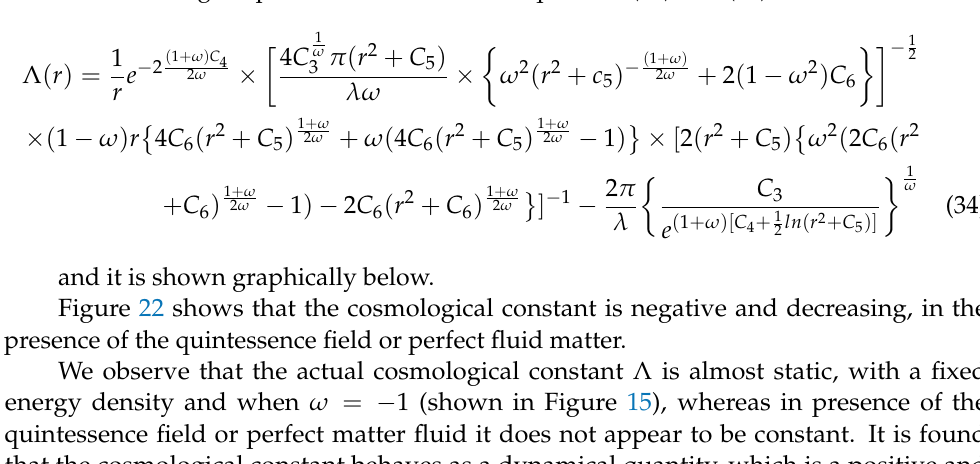
Figure 21. The energy conditions for perfect matter fluid source are plotted against the radial parameter r with the values of the arbitrary constants C 3 = 2, C 4 = 0.001, C 5 = 10. The cosmological parameter results from Equations (16) and (17)